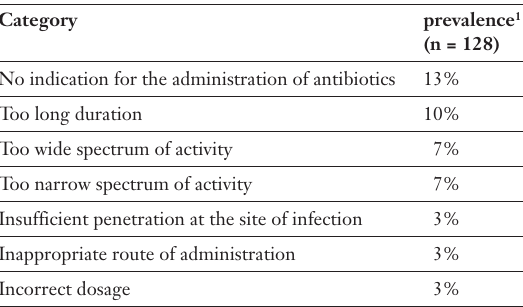
Prevalence of the categories of antibiotic